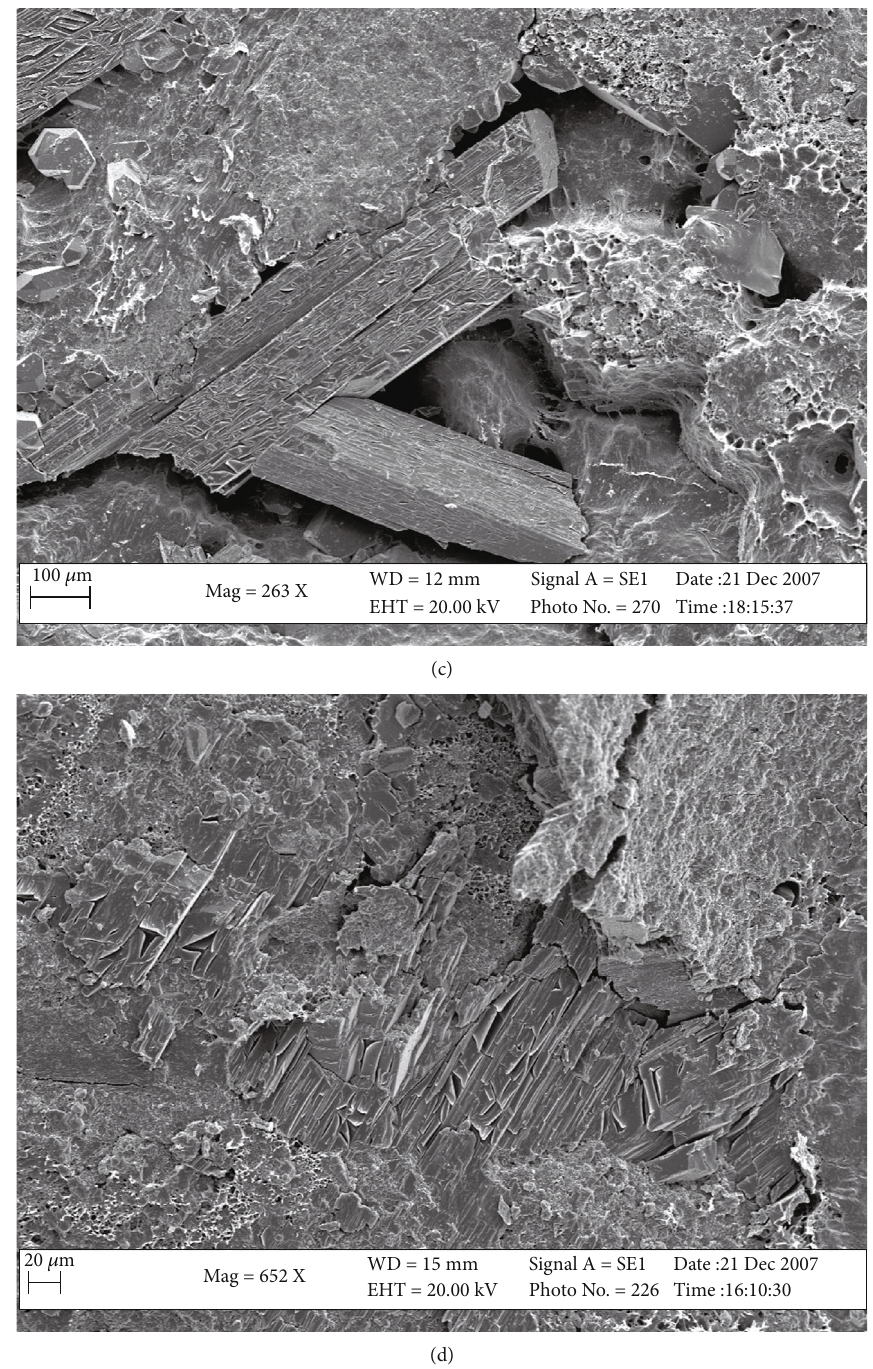
Figure 4: Scanning electron microscopy image of the Wu 2 section in the Ke017 well area. (a) Ke018, 3061.5m, platy zeolites; (b) Ke017, 3094.33m, equiaxed granular pyrite crystals; (c) Ke017, 3101.16 m, intergranular packing; (d) Ke018, 3064.04m, intergranular fi